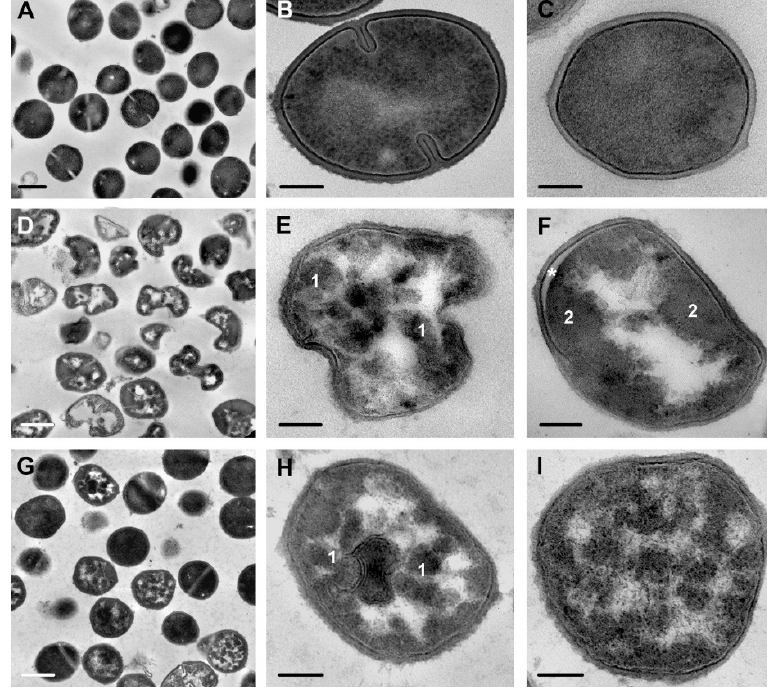
Figure 4. S. aureus cells: ( A – C )—control cells; ( D – F )—cells incubated with peptide R9F2 for 15 min, all cells are deformed and possess “empty” areas in cytoplasm. ( G – I )—cells incubated with (KFF)3K peptide for 15 min, di ff erent degree of damage to cytoplasm is observed. Note the alteration of the intermediate layer and undulation of cell membrane lipid layer on image I. 1—amorphous clumps in cytoplasm; 2—electron dense amorphous cytoplasm at cell periphery; asterisk shows widening of lipid layer. TEM of ultrathin sections. Scale bars correspond to: ( A , D , G ): 500 nm, other 100